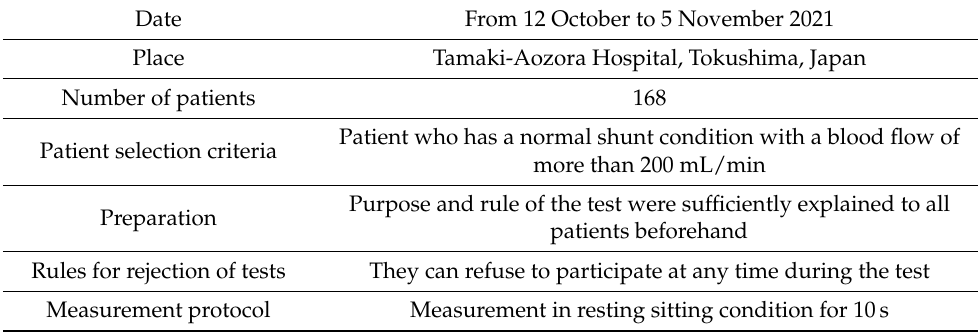
Figure 3. Setup and analysis flow of the non-contact AVF measurement system. Table 1. Information and protocol of clinic